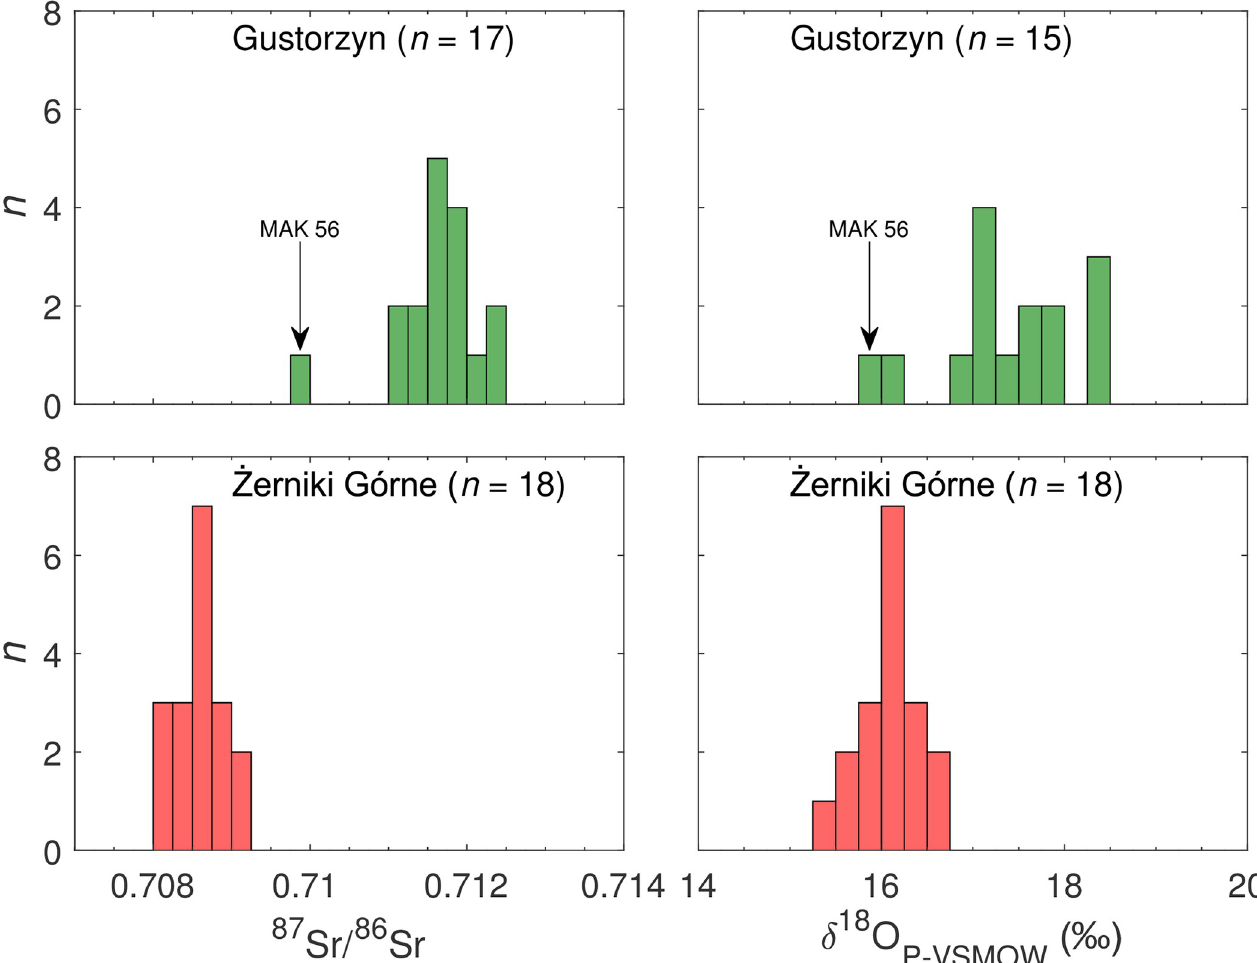
Fig 3. Strontium ( 87 Sr/ 86 Sr) and oxygen ( δ 18 O P-VSMOW ) isotope composition in tooth enamel of humans from cemeteries in Gustorzyn and Ż erniki Go´rne.